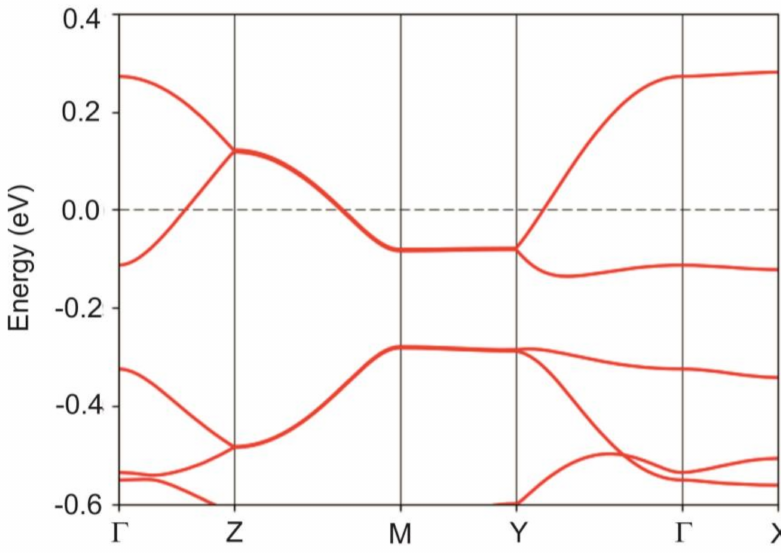
Figure 4. (Color online). Calculated band structure for the 300 K crystal structure of κ -ET-Cu. The energy zero corresponds to the Fermi level. Г = (0,0,0), X = (1/2,0,0), Y = (0,1/2,0), Z = (0,0,1/2), and M = (0,1/2,1/2) in units of the reciprocal lattice